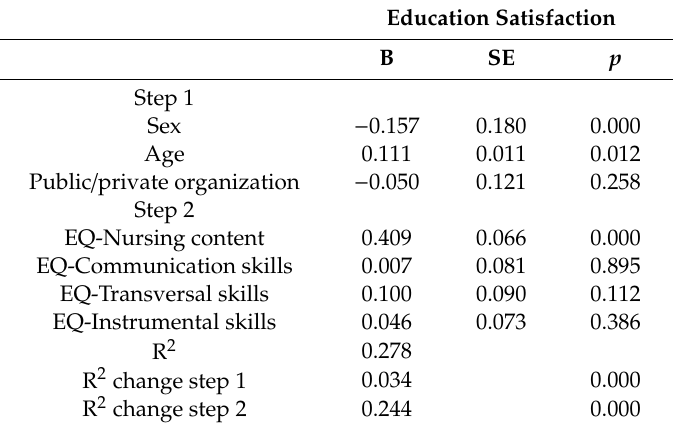
Table 4. Regression analysis of graduates’ retrospective Education Satisfaction on Education Quality (EQ-) factors. Education Satisfaction B SE p Step 1 Sex − 0.157 0.180 0.000 Age 0.111 0.011